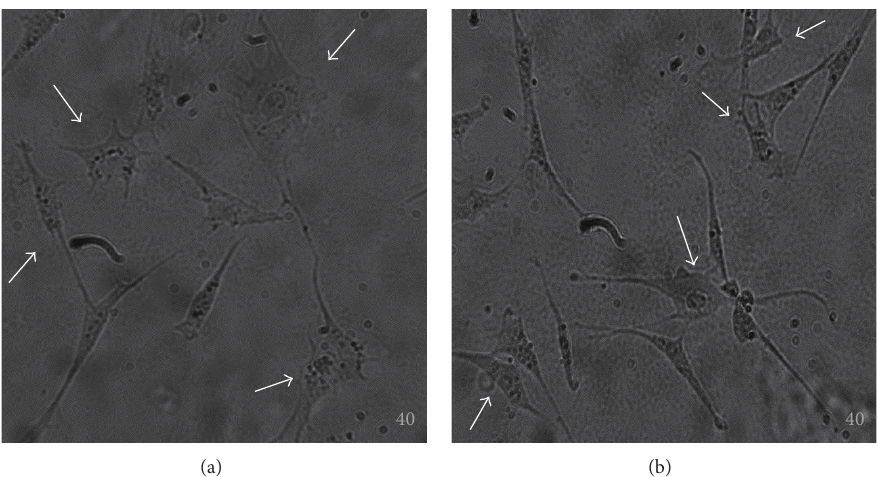
Figure 4: Transdifferentiation assay of eBM-MSCs. Representative images from one young (a) and one middle-aged (b) horse showing neural crest-like cells (white arrows) at 12h after chemical induction. Note the contraction of the cellular body and the appearance of multiple cell processes. Magnification = 40x.